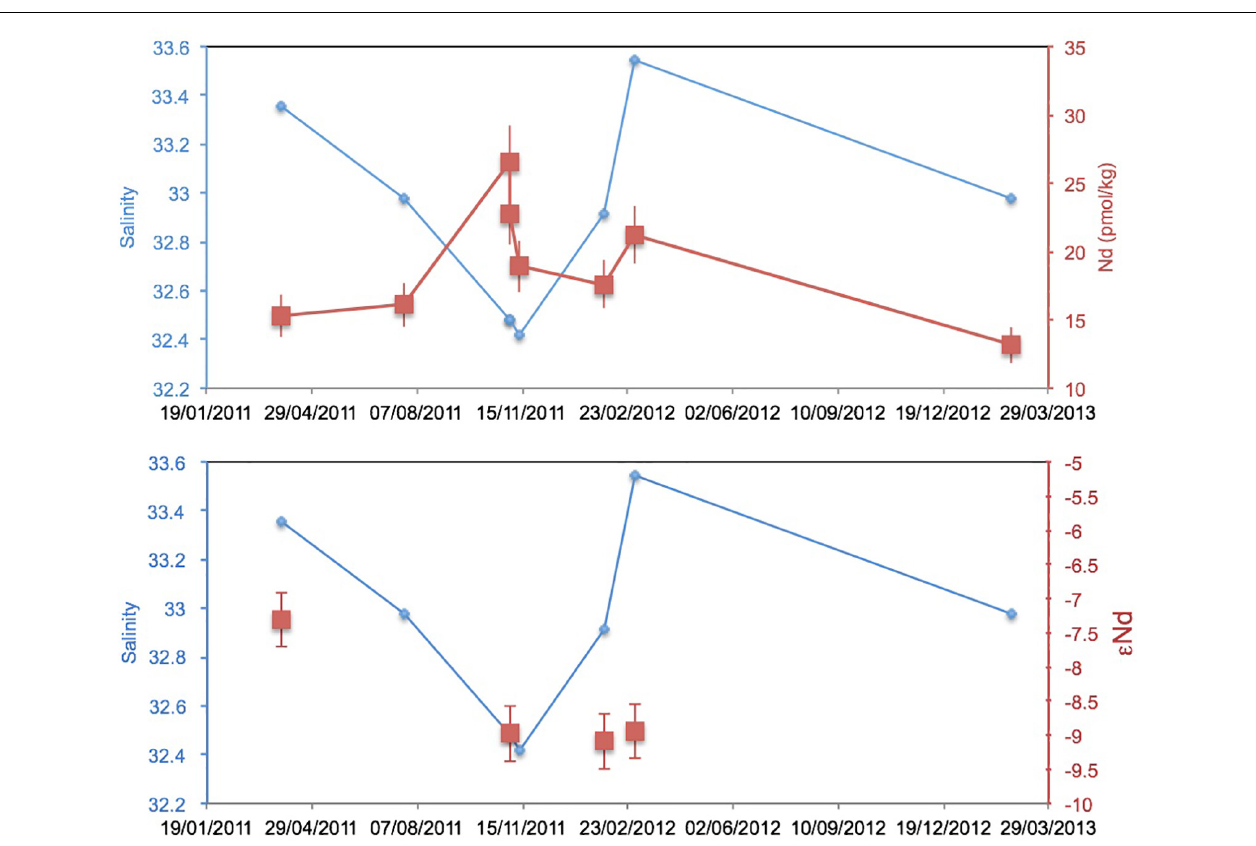
FIGURE 8 | Jolly Buoy Island time series of Nd isotope composition and Nd concentration with measured